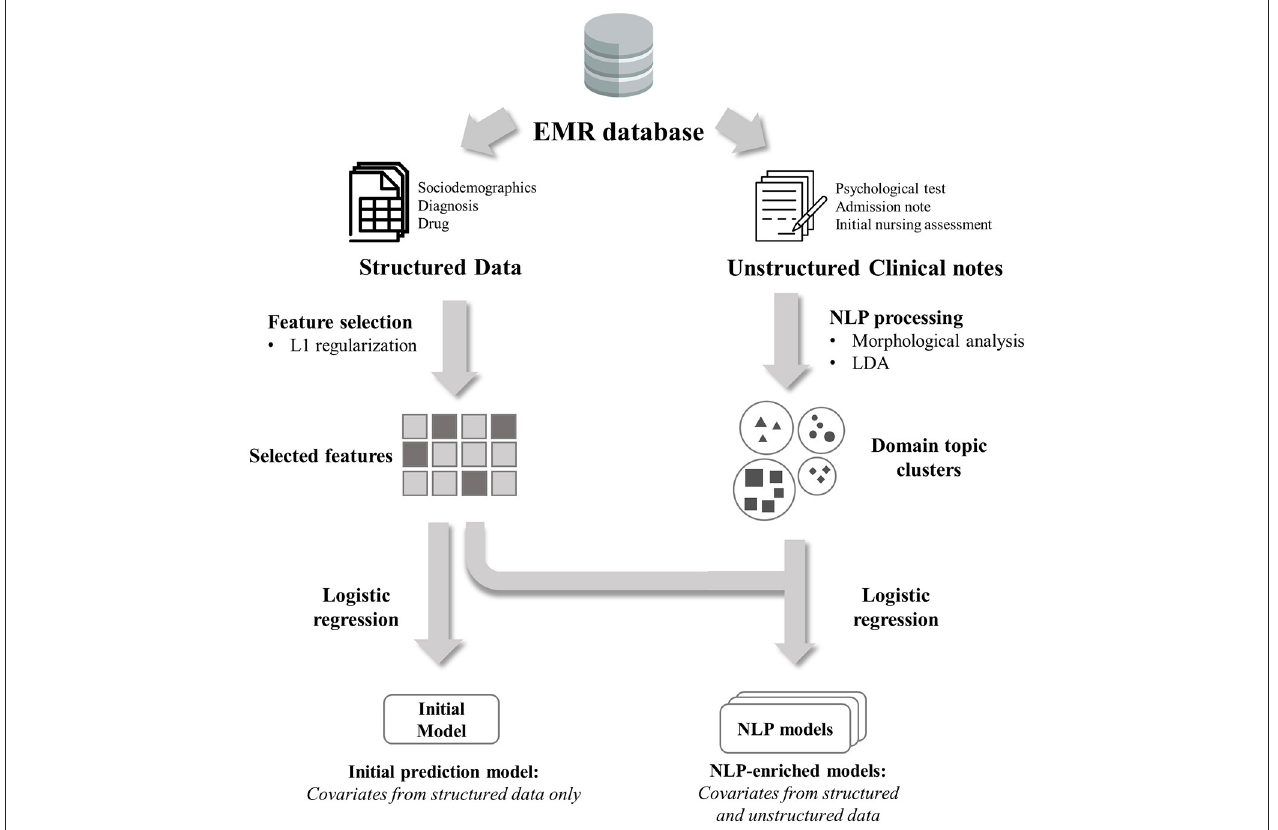
FIGURE 1 | Overview of model development process. Initial model was developed using selected features only from structured data. NLP-enriched models were developed using selected features plus features from unstructured clinical